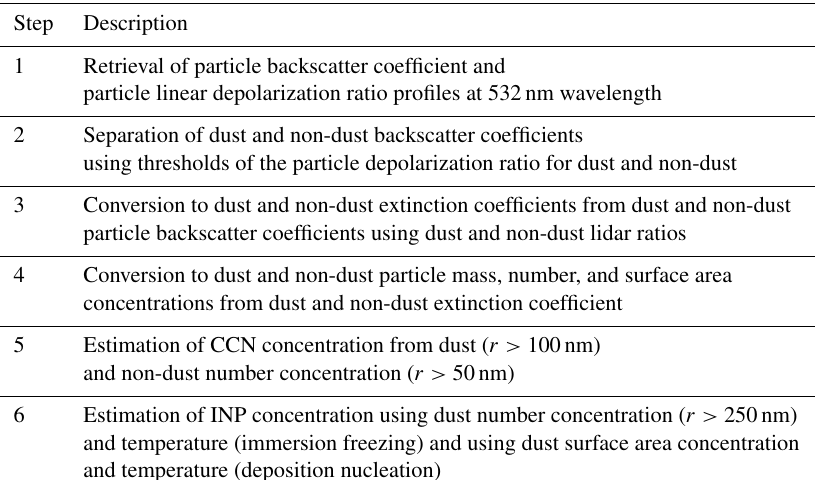
Table 1. Overview of the data analysis from the basic lidar-derived aerosol optical properties (particle backscatter and extinction coefficients, particle linear depolarization ratio) to the height profiles of CCN and INP concentrations. r denotes the particle radius.